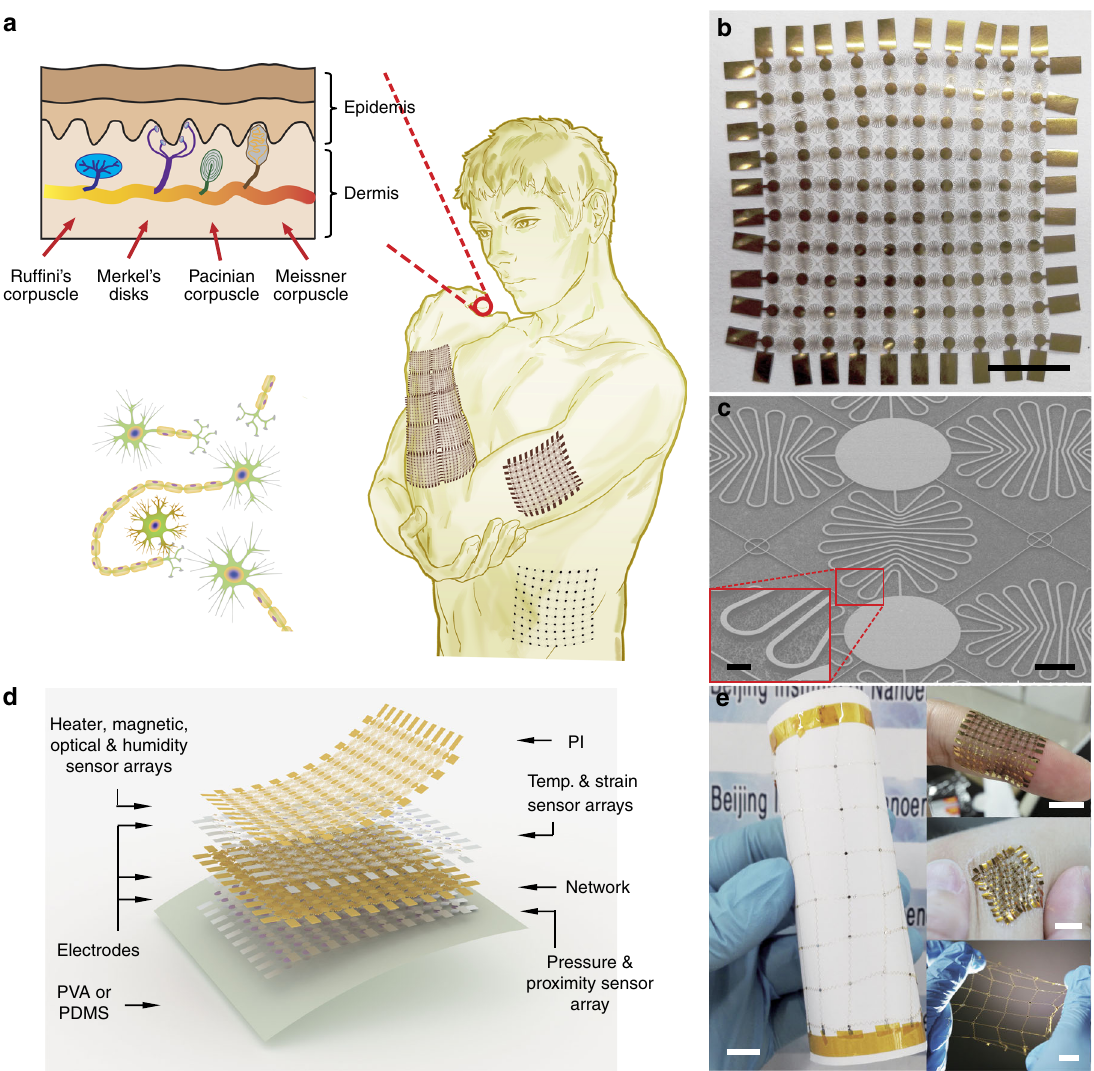
Fig. 1 Skin-inspired highly stretchable and conformable matrix networks. a Schematic illustration of SCMNs conforming to the surface of a human arm and an expanded network (expansion: 200%) conforming to the surface of a human abdomen (right); the tree branch-like connections of neurons (left bottom); the sensory receptors of the glabrous skin (left top). b Optical image of the fabricated polyimide network (10 × 10 array, scale bar: 5 mm). c Tilted SEM image of the polyimide network (scale bar: 500 μ m); the inset is a higher resolution SEM image of a meandering interconnect (scale bar: 50 μ m). d Schematic layout of an SCMN — an integrated sensor array with eight functions. (temp.: temperature). e Image of an SCMN attached to a sheet of paper, demonstrating ultrahigh fl exibility and stretchability. The inset (upper) shows an SCMN conforming to a human fi nger, (middle) an SCMN attached to human skin with compression, and (bottom) an SCMN stretched by a human hand (scale bar: 1